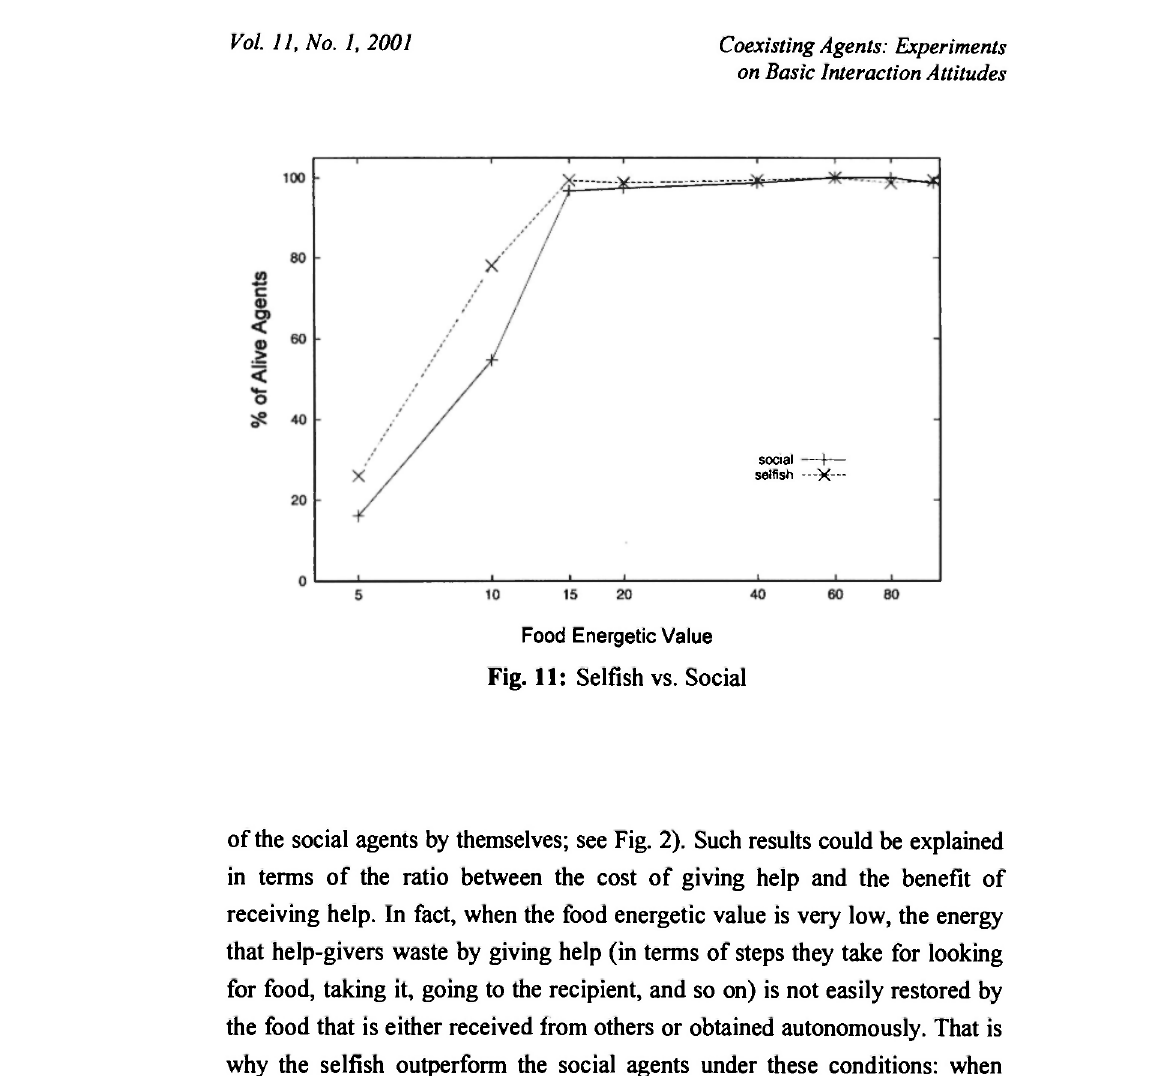
Fig. 11: Selfish vs. Social